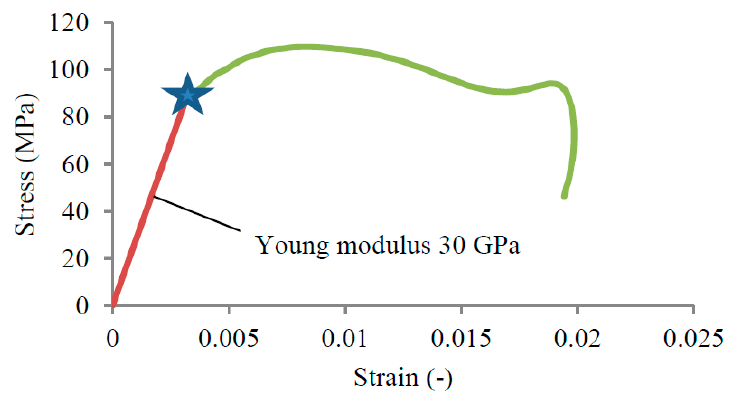
Figure 9. Material behavior description of concrete under dynamic compression based on the process of elastic wave propagation with an impact velocity of 30 m/s (strain rate 435 (s − 1